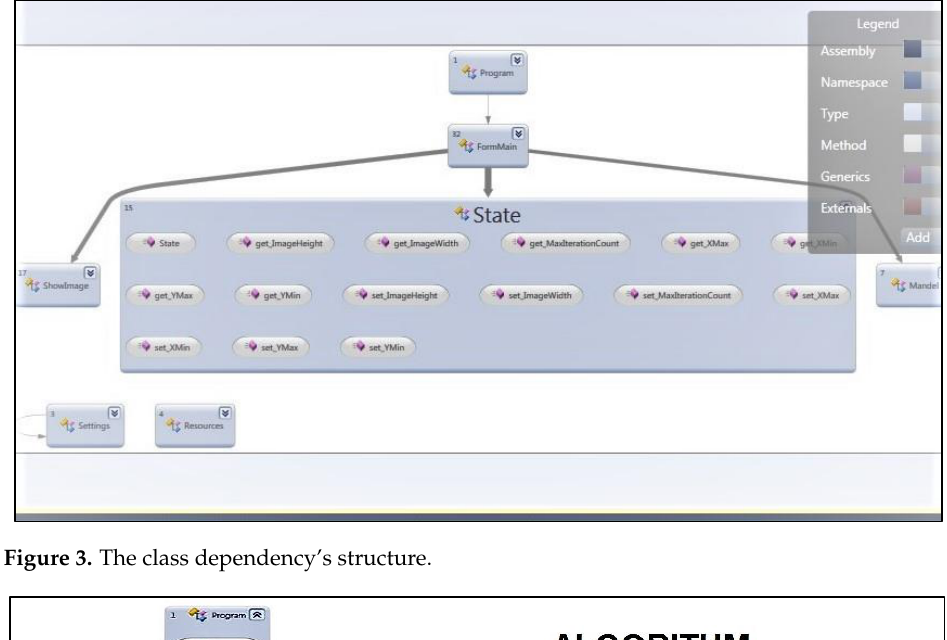
Figure 3. The class dependency’s structure.